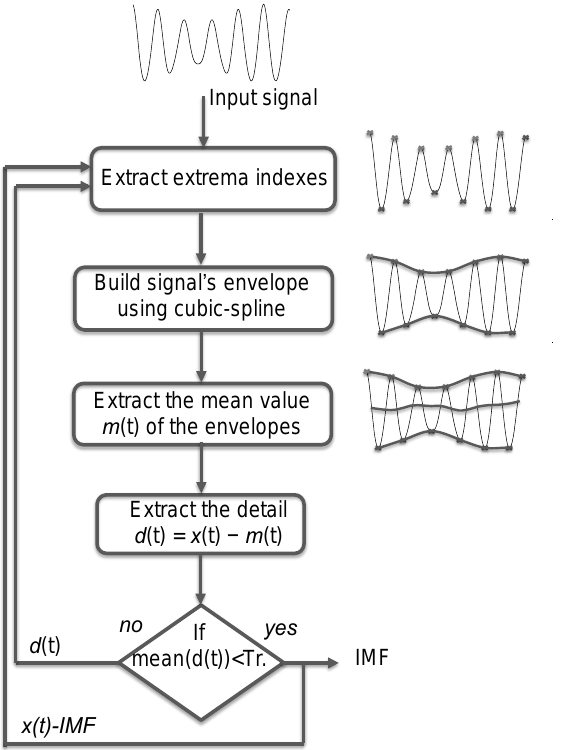
Figure 1. Block diagram summarizing the basic EMD